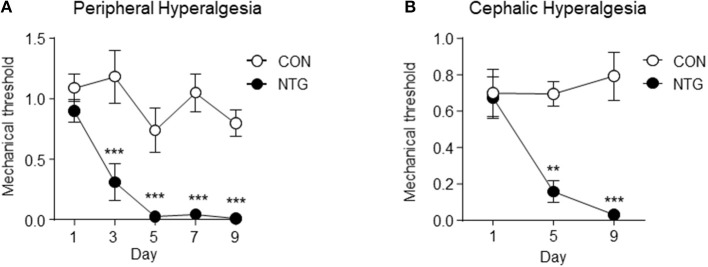
Peripheral (A) and cephalic (B) mechanical threshold indicator of hyperalgesia in the chronic nitroglycerin (NTG) or control (CON) mouse groups across day of treatment. Mechanical thresholds were determined before each injection using von Frey filaments. Two-way analysis of variance including the effects of treatment, day, and interaction; A. Hindpaw measurement (n = 5/group); treatment, day, interaction P-value < 0.01; *** within day Holm-Sidak testing P-value < 0.001. (B) Periorbital region caudal to the eyes measurement (n = 6/group); treatment, day, interaction P-value < 0.05; ** within day Holm-Sidak testing P-value < 0.01, ***P-value < 0.001. Results are represented as mean ± SEM.